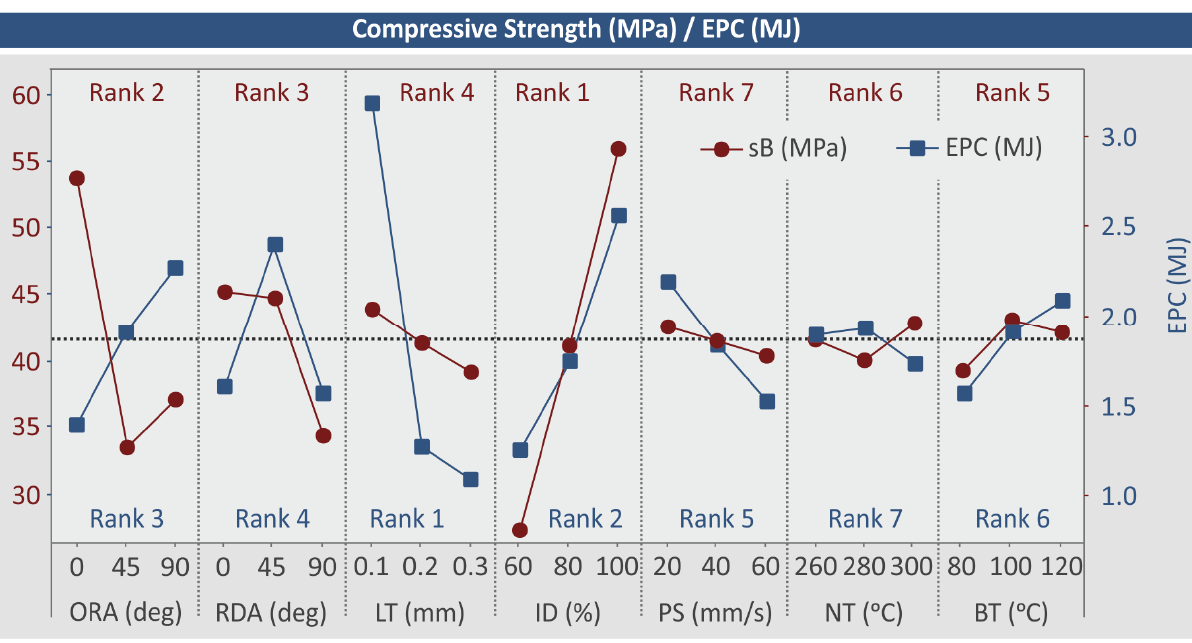
Figure 9. MEP for the compressive strength (MPa) and the energy (MJ) vs. the control parameters of this